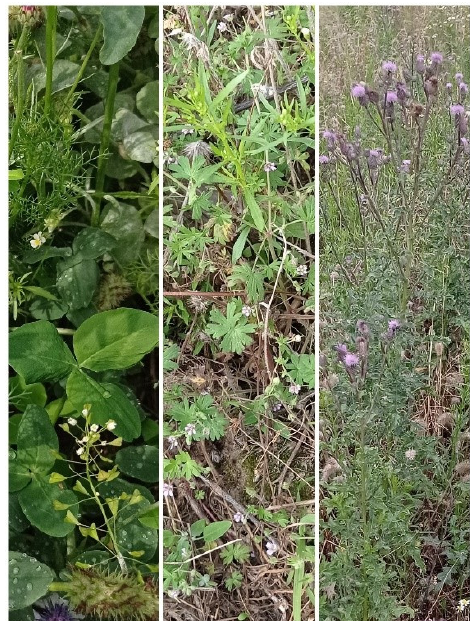
Figure 1. Weeds appearing spontaneously in flower strips. Left to right: heartsease ( Viola tricolor L.) and shepherd’s purse ( Capella bursa-pastoris (L.) Medik.), small-flowered crane’s-bill ( Geranium pusillum L.), creeping thistle ( Cirsium arvense (L.) Scop.) and horseweed ( Conyza canadensis L.) (authors’ observations, 2022).